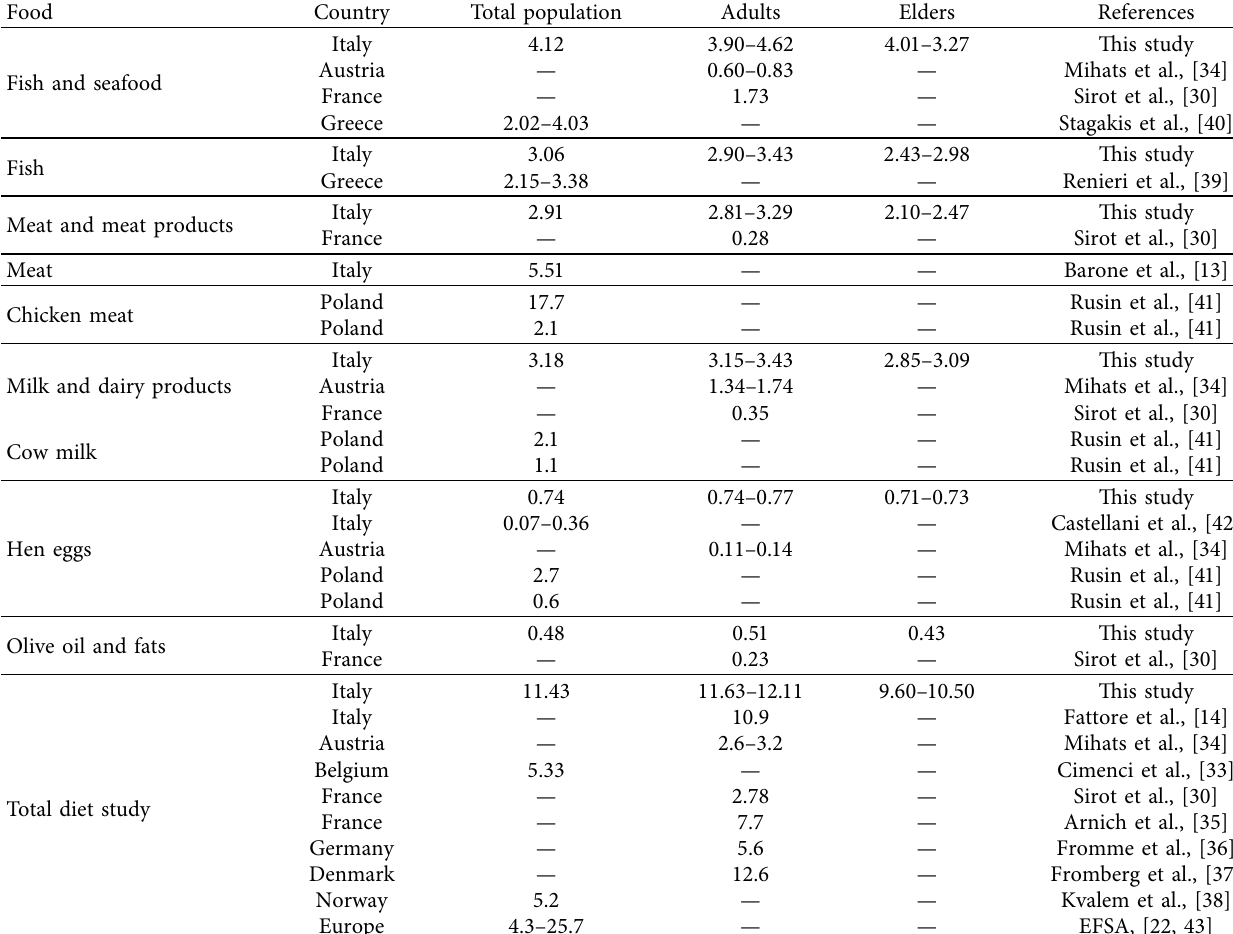
Table 5: Estimated intake of iPCBs’ comparison with other European